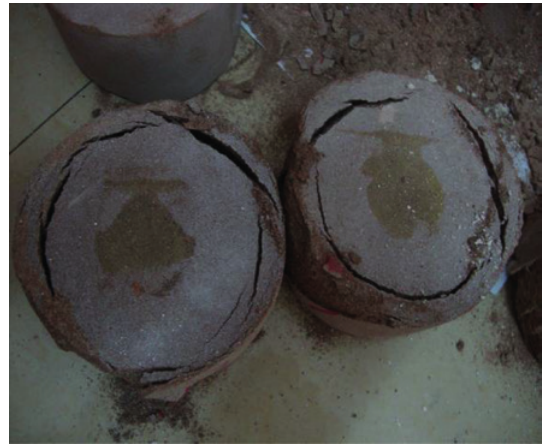
Fig. 5: The exterior shape of sandstone that stays two days indoors after the high temperature of 1000 °C